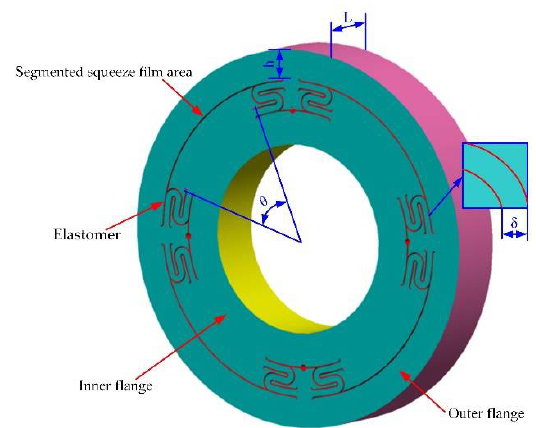
Figure 1. Integral squeeze film bearing damper model.